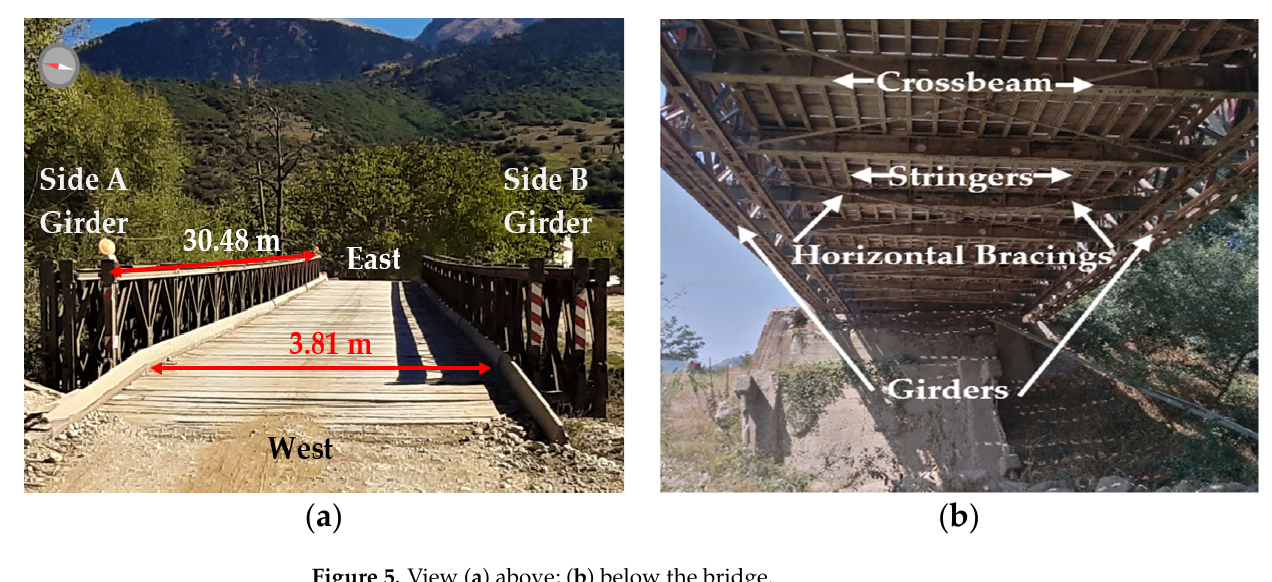
Table 5. Bailey bridge cross restrictions.